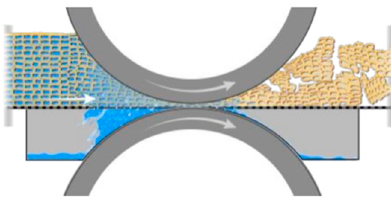
Figure 2. A concept picture of the mechanical dewatering continuous dewatering press (CDP) technique.